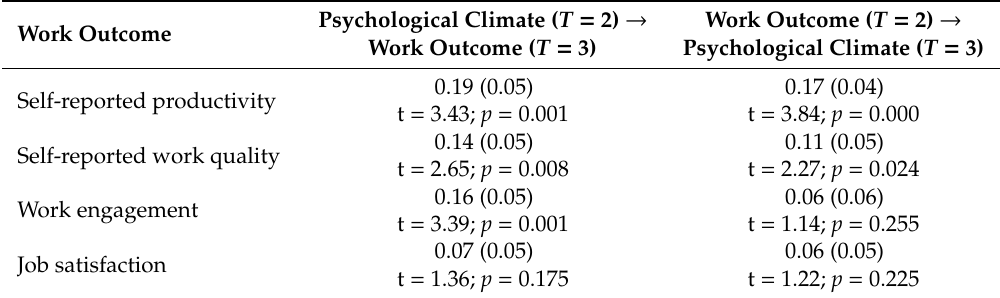
Table 3. Standardized regression coe ffi cients (standard errors in parenthesis) for the relationships between perception of psychological climate for caring and work outcomes ( n = 495). Work